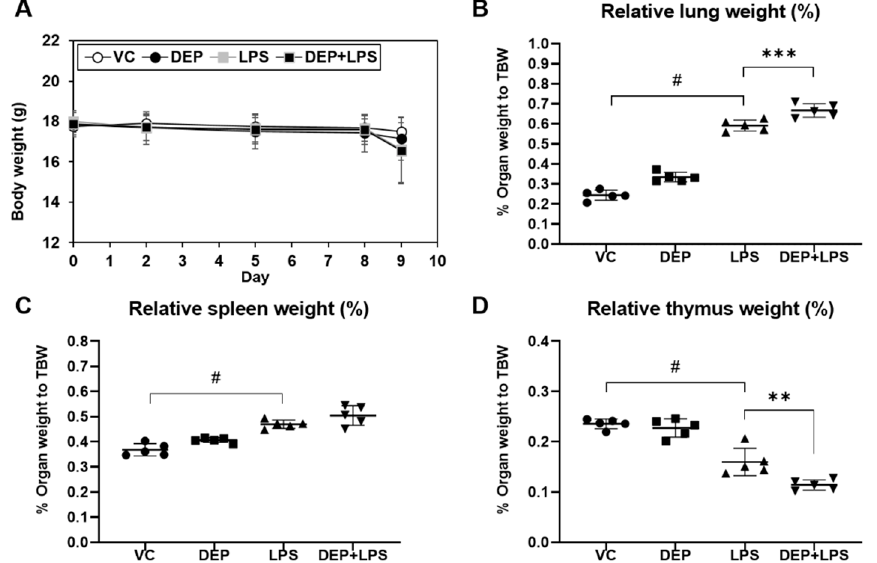
Figure 2. Changes in ( A ) body weight and ( B – D ) relative organ weight in vehicle control (VC), DEP, LPS, DEP pre-exposed, and LPS-instilled (DEP+LPS) groups. Relative weights of the ( B ) lung, ( C ) spleen, and ( D ) thymus were calculated using the following formula: relative organ weight = organ weight (g)/final body weight (g) × 100%. Data represent means ± SD (n = 5 per group). # p < 0.05 vs. VC, ** p < 0.01 or *** p < 0.001 vs. LPS